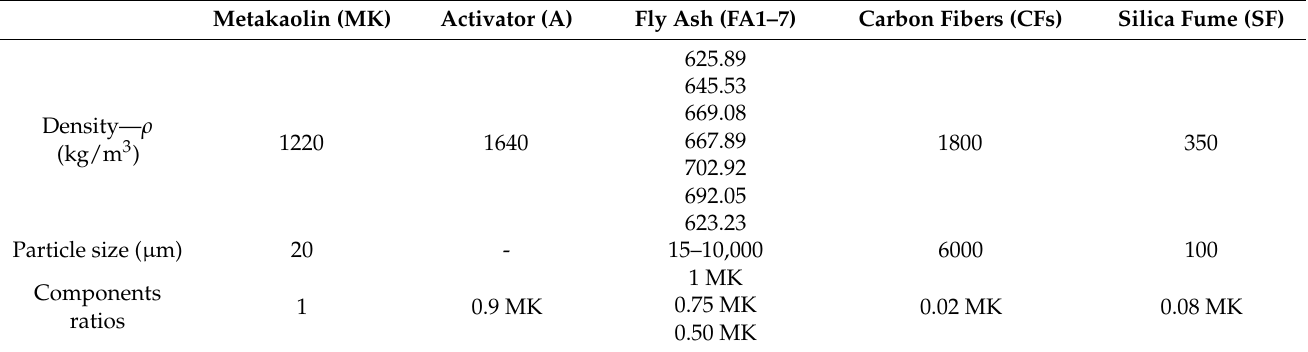
Table 5. Physical characteristics and weight ratios (related to MK) of each geopolymer component. Metakaolin